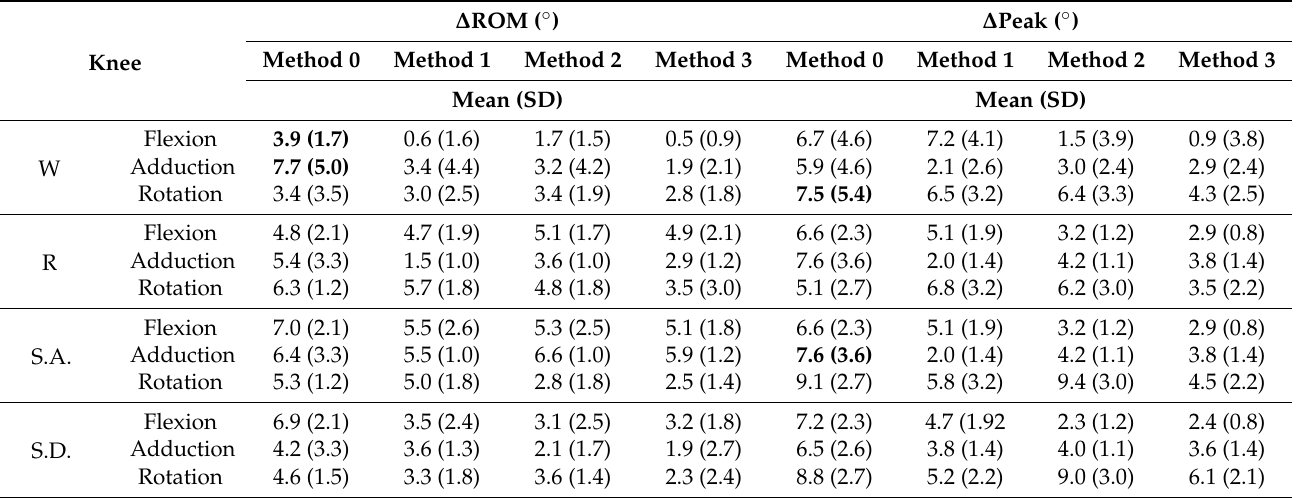
Table 2. Values between calibration methods and MoCap during the different motions for knee joint. ∆ ROM: absolute difference in range of motion, ∆ Peak: absolute difference in max peak, SD: